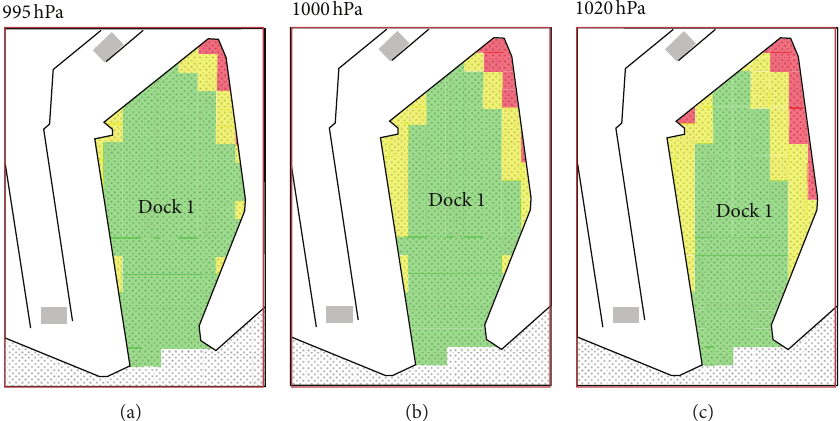
Figure 15: Bathymetric map of a dock in the Port of Livorno depending on the atmospheric pressure (995 hPa, 1000hPa, and 1020hPa); the three colours (green, yellow, and red) indicate three water depth ranges (very deep, deep, and not deep) (image from